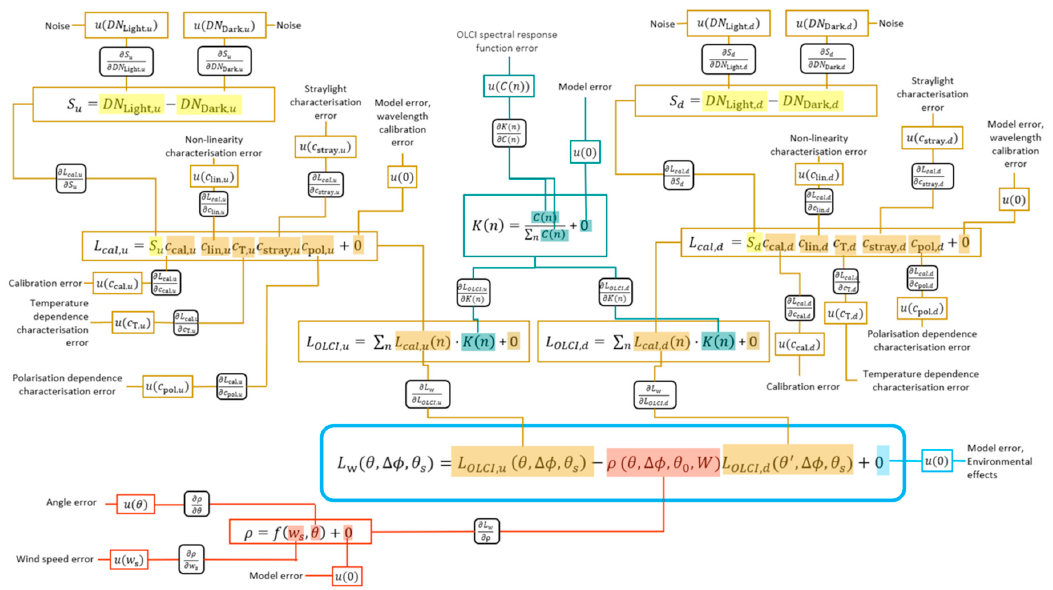
Figure 25. Uncertainty tree diagram for water leaving radiance ( L w ). Reproduced with permission from [56].